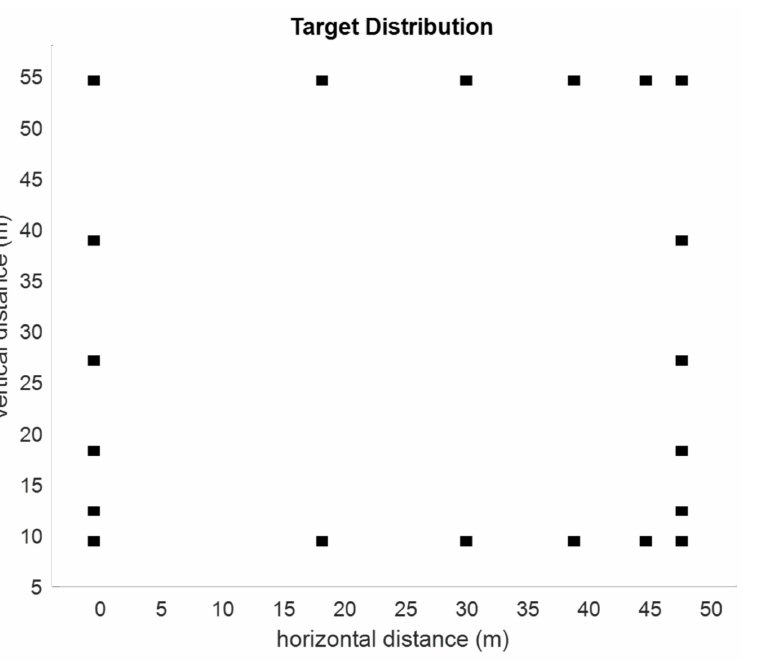
Figure 19. Distribution of targets with constant radar reflectivity used as input to the 2D simulations.